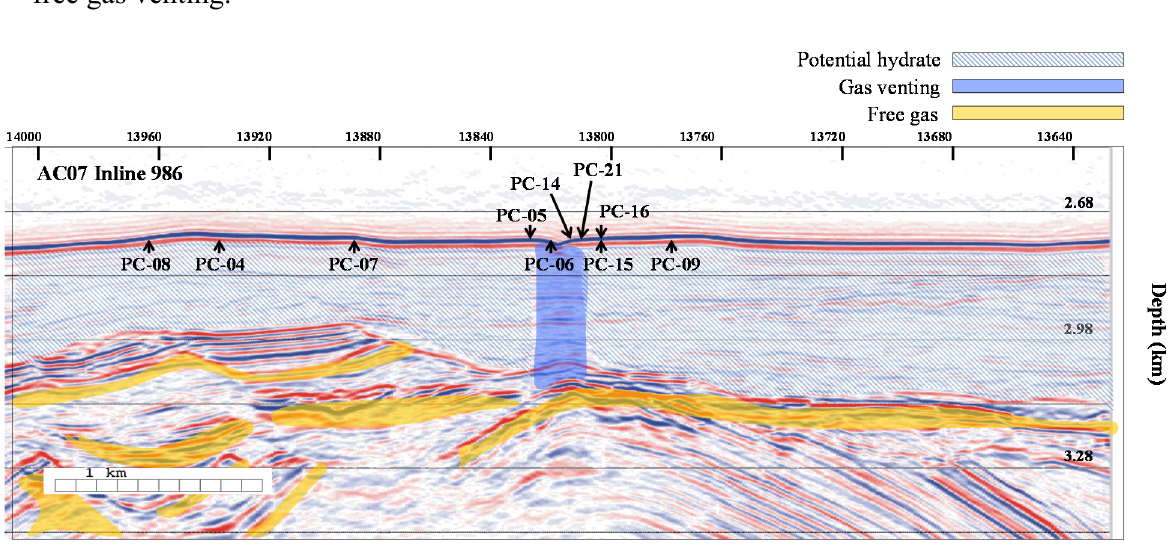
Figure 2. Locations for piston cores collected during the AC-07 research expedition along the WesternGeco seismic profile for Inline 986. The seismic profile has been colorized to indicate areas of potential hydrate deposits located above interpretation of free gas zones and free gas